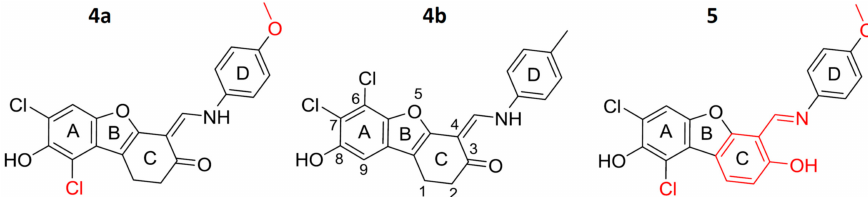
Figure 1. New dibenzofuran derivatives 4a and 5 tested for CK2 inhibition. Structural differences between the compounds are given in red. Compound 4b was published before [28,37] and was therefore used as a